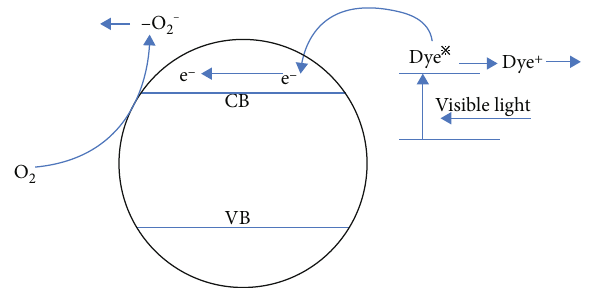
Figure 6: Mechanism of dye-sensitized titanium dioxide photocatalytic